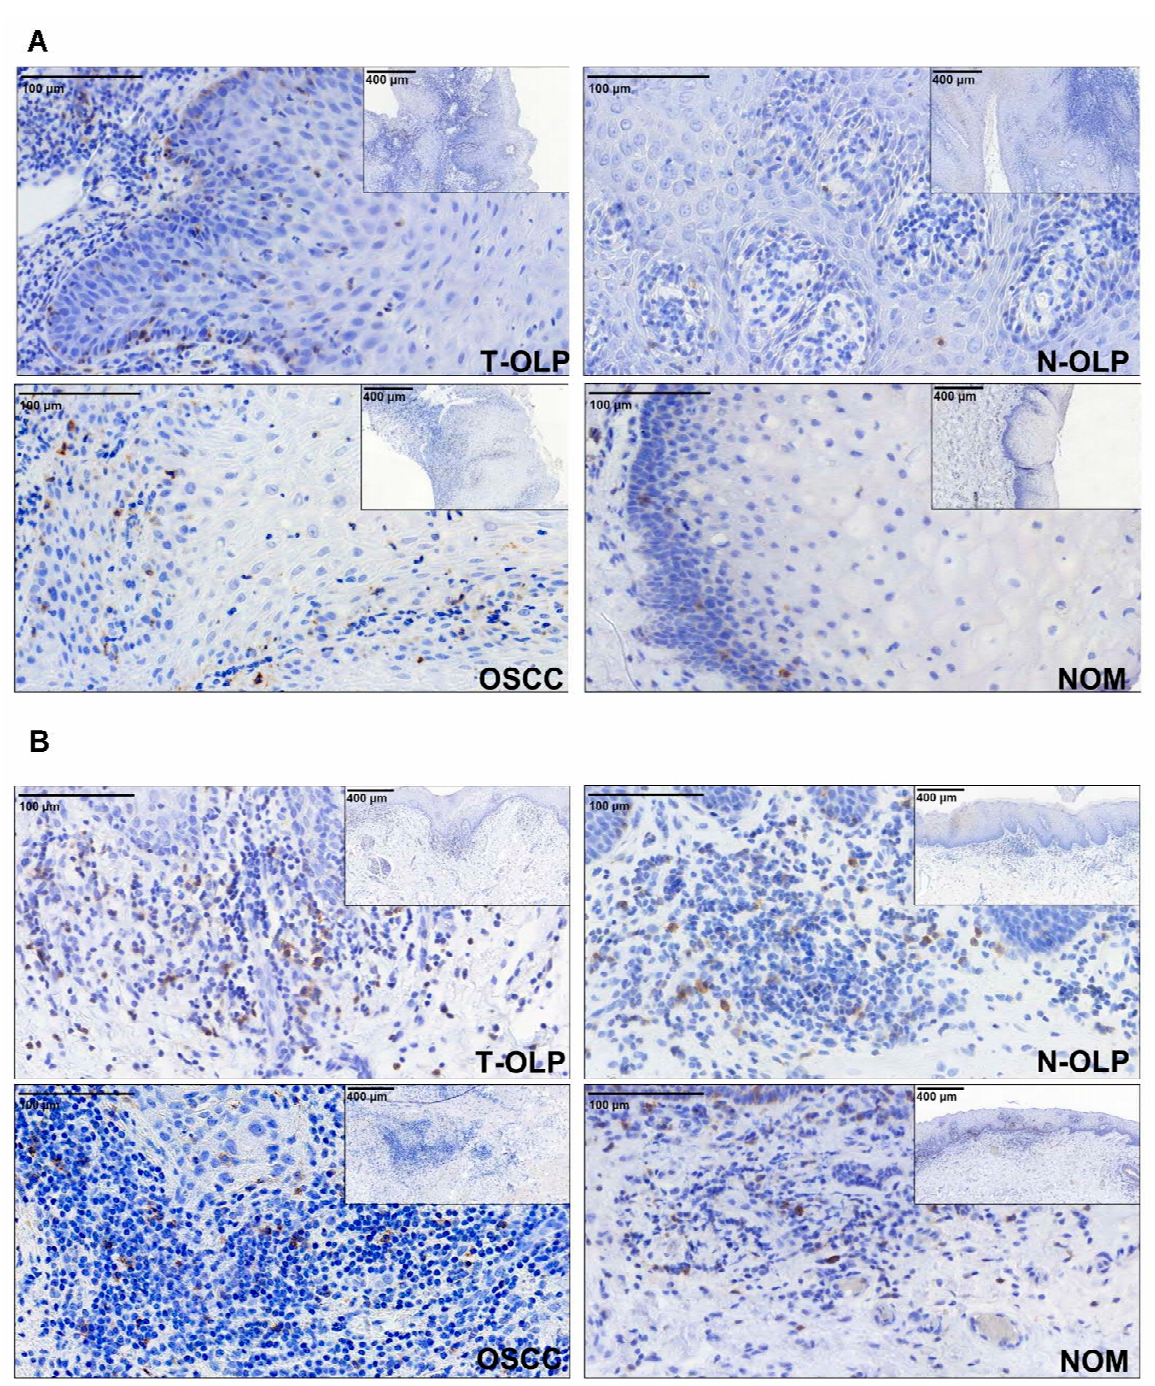
Figure 1. Immunohistochemical expression analysis of PD-1. The expression of the proteins was separately analyzed in the epithelium ( A ) and the subepithelium ( B ). Differential expression between the different tissues was observed.